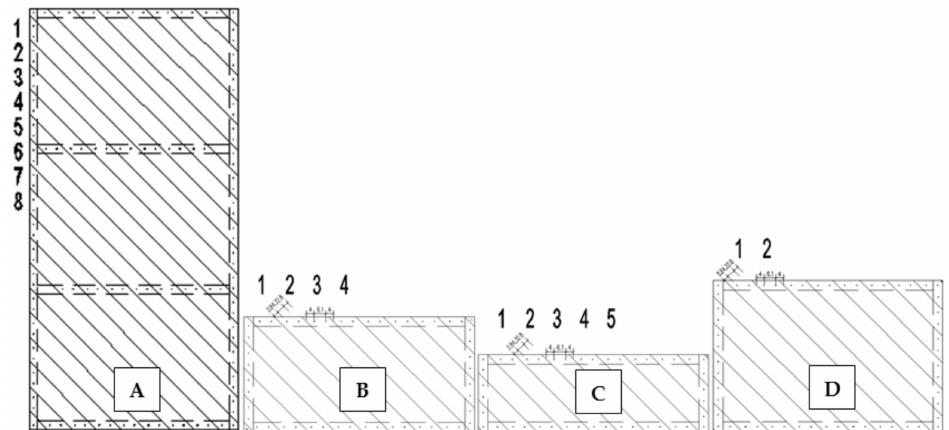
Figure 2. CLT-mangium lumber connection forms a shear wall slant body. ( A ) full-size shear wall panel type A; ( B ) shear wall panel type B; ( C ) shear wall panel type C; ( D ) shear wall panel type